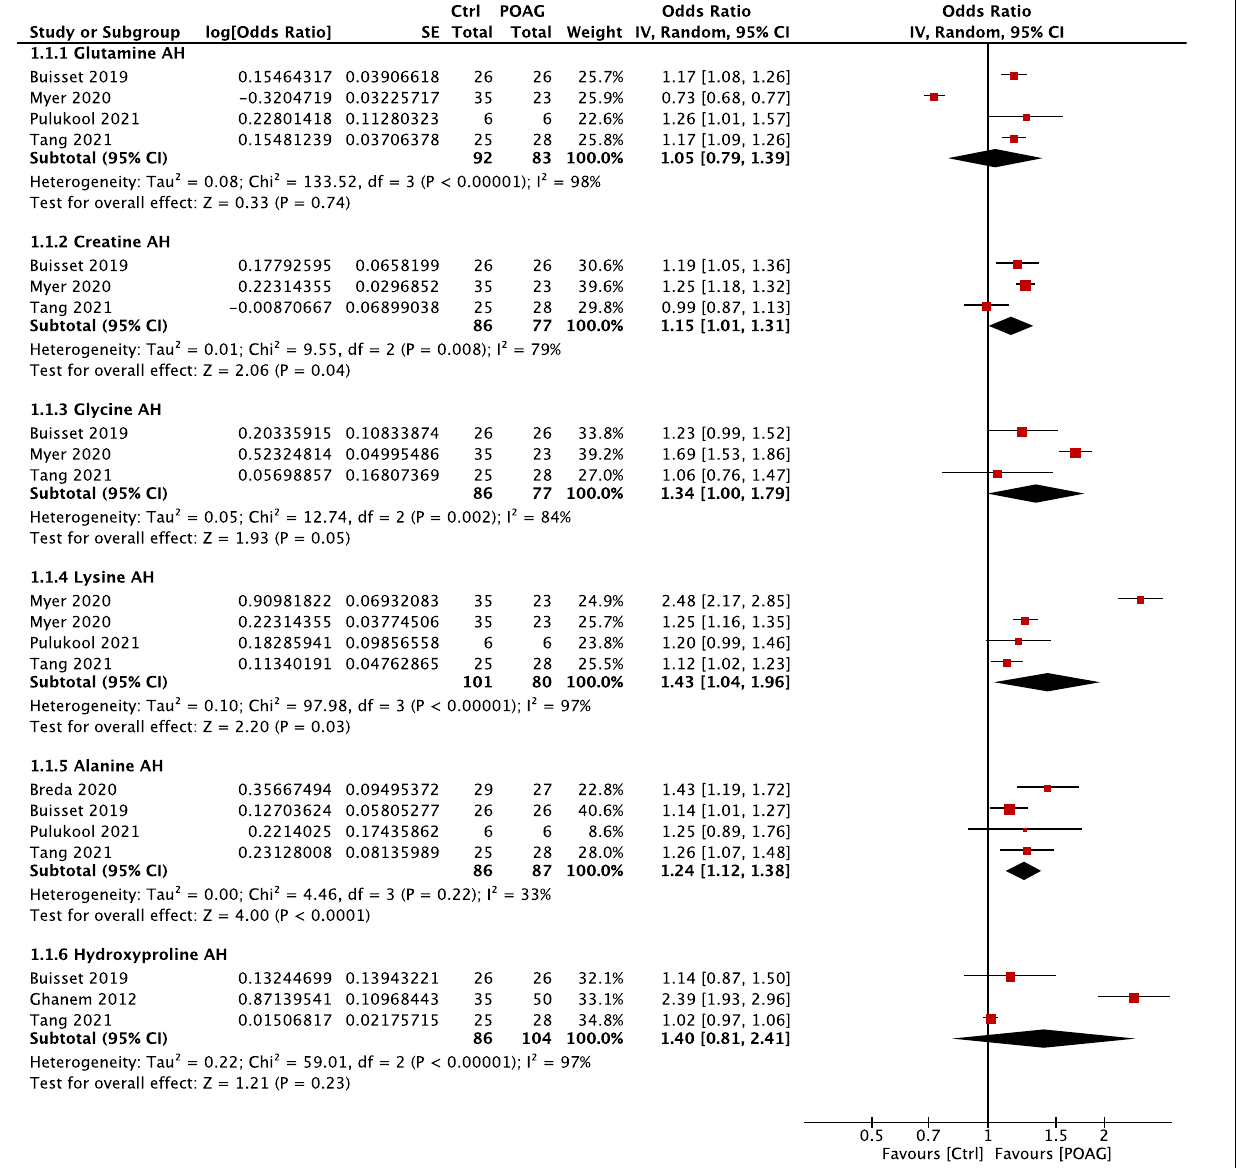
FIGURE 3 | Forest plot of the metabolites in the aqueous humor of patients with POAG compared to controls using a random-effect model. Odds ratio (OR) and 95% confidence intervals (95% CI) were given. The position of the red squares and the horizontal black lines correspond to OR and 95% CI of each study, respectively. The size of the square stands for the weight of the study. The overall OR was displayed by the black diamond, the width of which shows the overall 95% CI of per metabolite. The I 2 and p -value for heterogeneity were displayed and the p -value for each metabolite is shown after the test for overall